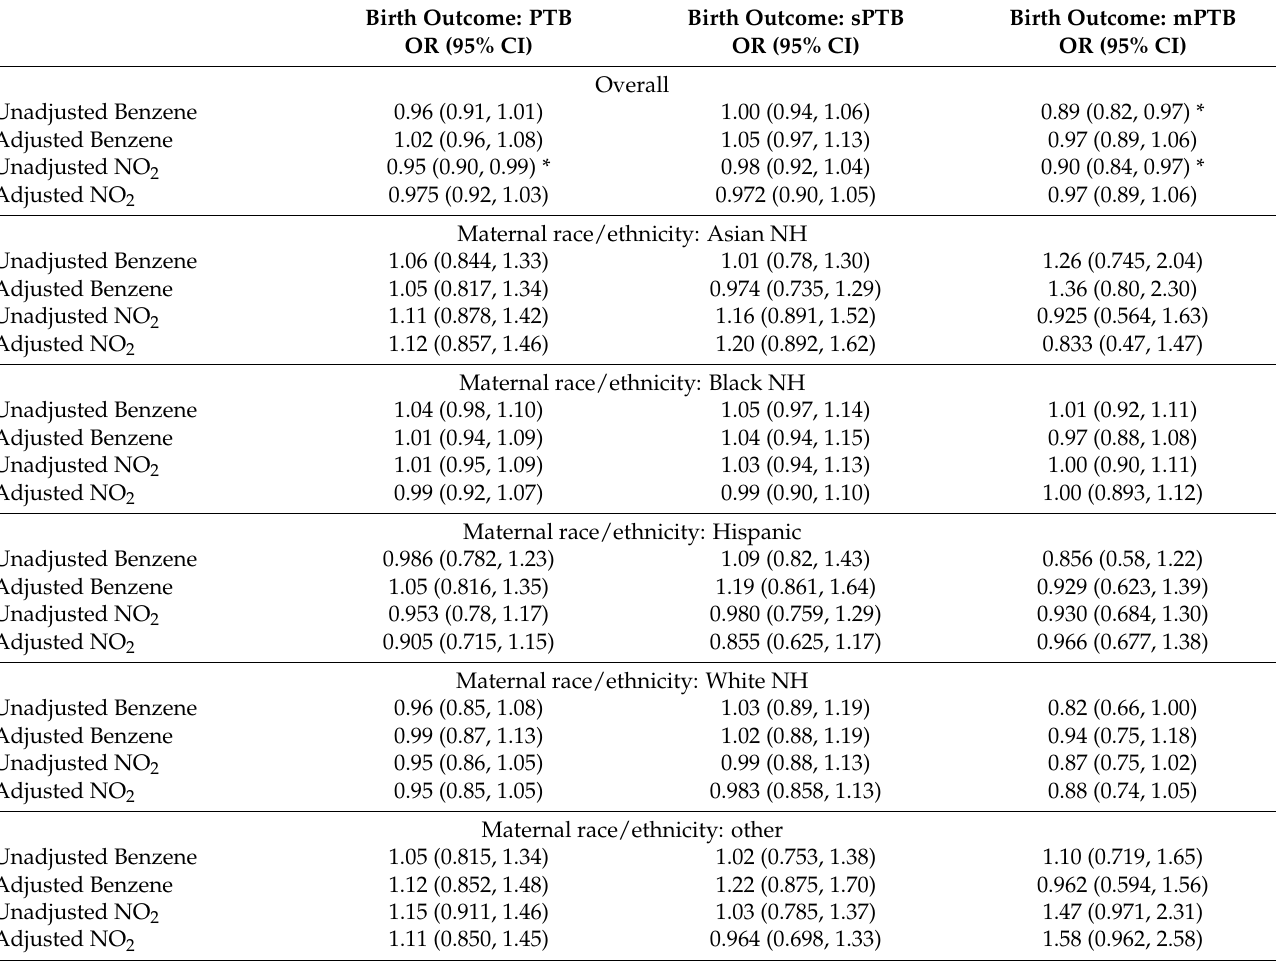
Table 2. Unadjusted and adjusted a odds ratios (ORs) of a standard deviation increment increase in NO 2 and benzene with preterm birth (PTB) outcomes, including spontaneous (sPTB) and medically indicated